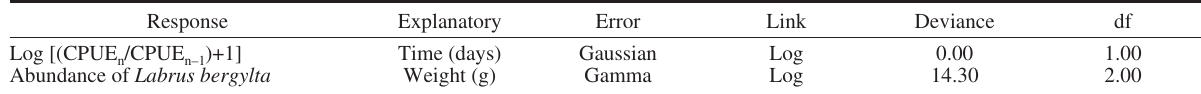
Table 2. – Significant variables, error distribution and link, explained deviance and degrees of freedom (df) of the GAM fitted to the rate of change of the CPUE between pairs of consecutive competitions and to the abundance of Labrus bergylta obtained by UVCs. The models fitted to the abundance of fish species with non-significant variables are not